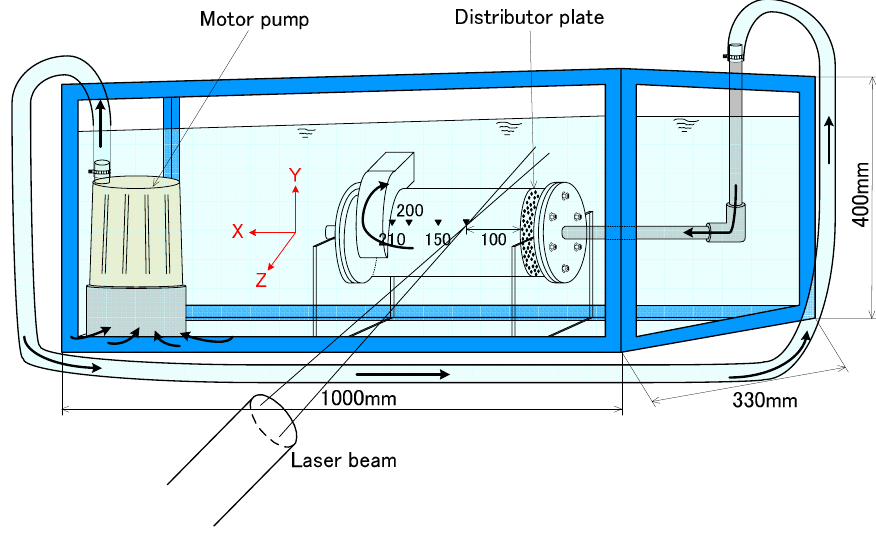
Fig. 6 : Schematic diagram of the experimental set-up for LDV